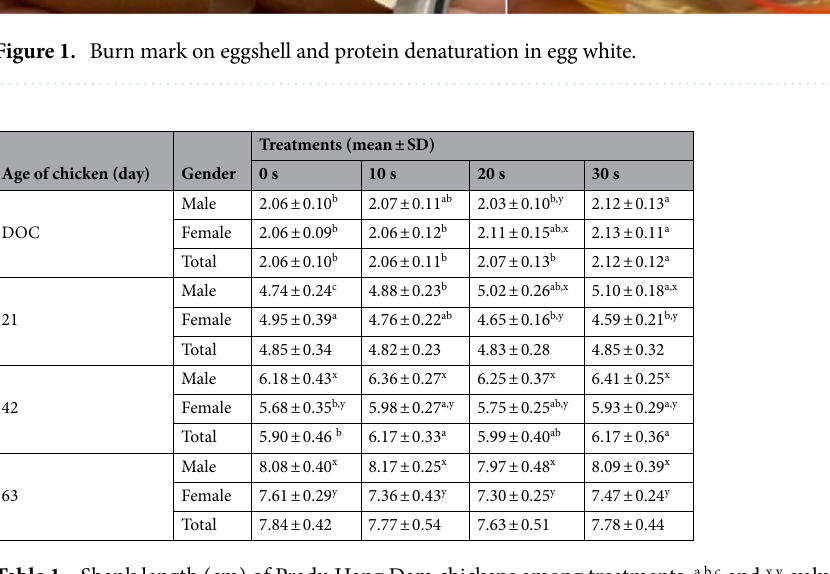
Table 1. Shank length (cm) of Pradu Hang Dam chickens among treatments. a,b,c and x,y , values with different superscript letters in a column and row, respectively, are significantly different (p-value <